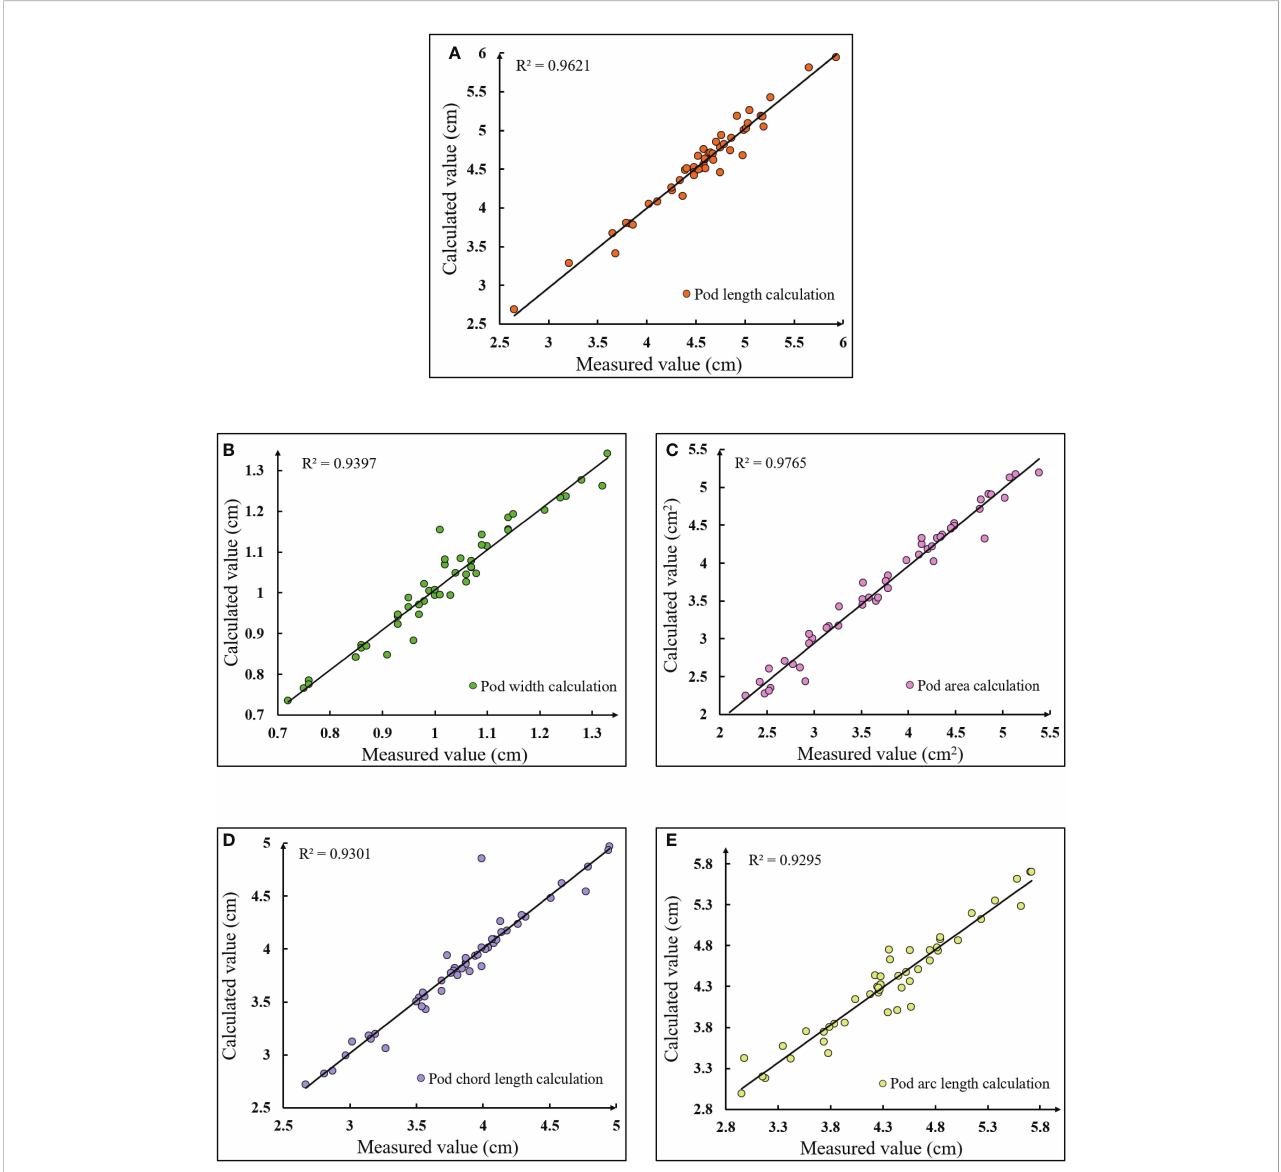
FIGURE 14 Linear correlation between calculated and measured values of pods phenotypic traits (A) Pod length calculation; (B) Pod width calculation; (C) Pod area calculation; (D) Pod chord length calculation; (E) Pod arc length